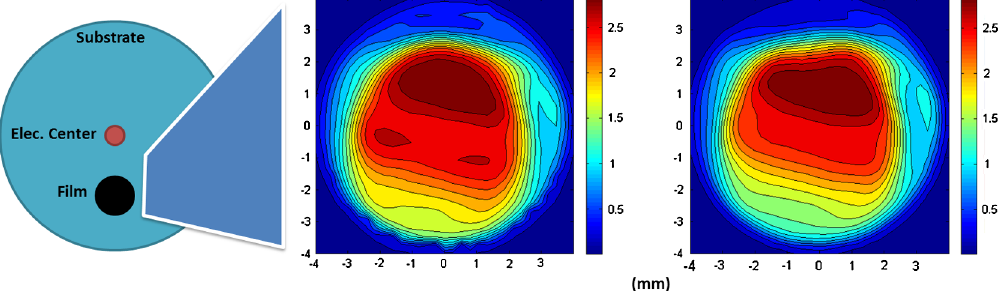
FIG. 1. A schematic of the photocathode substrate and film is shown at left. The QE (%) map of the photocathode is shown before running (middle) and after (right). The laser spot had a diameter of 1.75 mm. The laser spot was centered horizontally, and displaced approximately 1 mm vertically above the center of the active area.